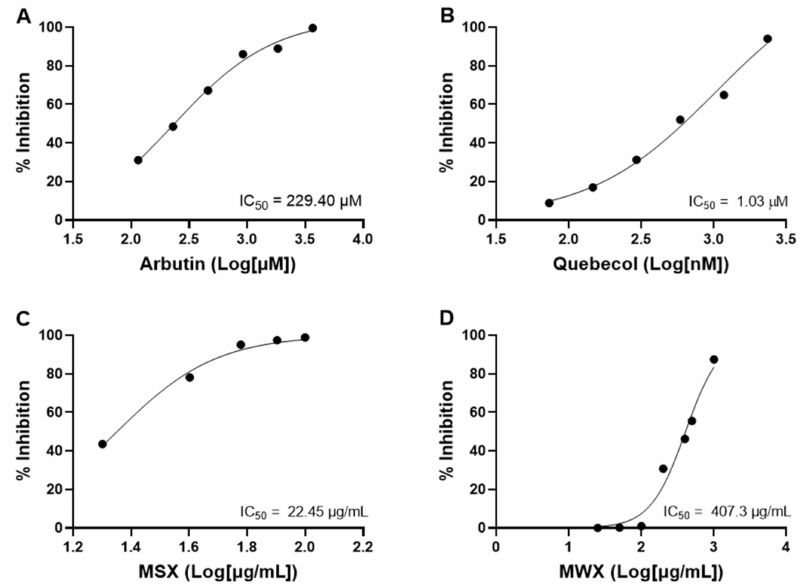
Figure 6. Antioxidant effects of arbutin ( A ), quebecol ( B ), MSX ( C ), and MWX ( D ), evaluated by a tyrosinase inhibition assay.